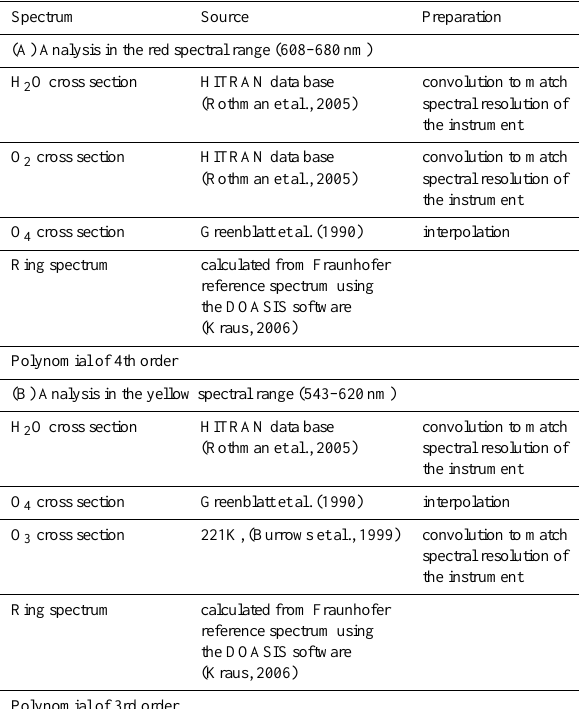
Table 1. Settings used for the spectral